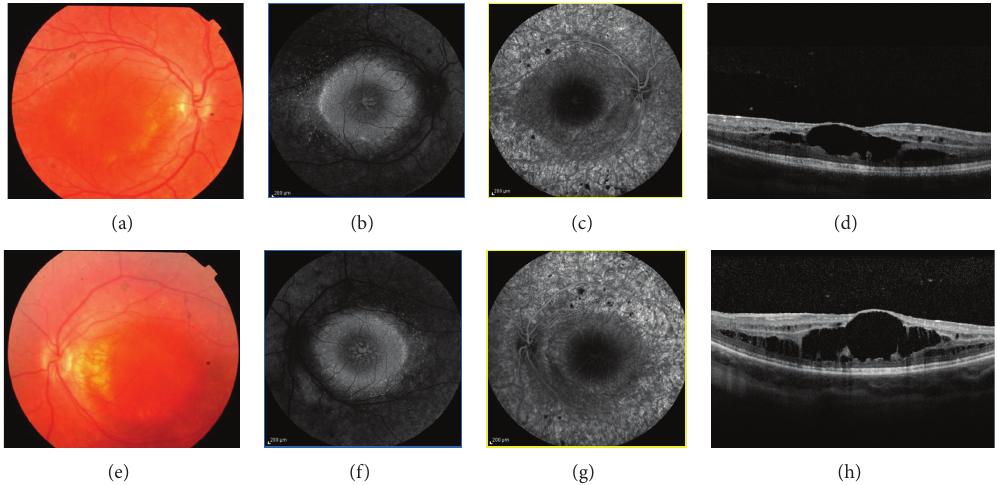
Figure 6: Color fundus photography of a patient with enhanced s-cone syndrome showing nummular pigmentary clumping at the level of the RPE along the vascular arcades and macular disturbance with subtle pigmentary changes; fundus autofluorescence shows an absence of AF outside the arcades and a ring of increased AF at the posterior pole. Foveal schisis is demonstrated on SD-OCT and confirmed by the absence of leakage on fluorescein